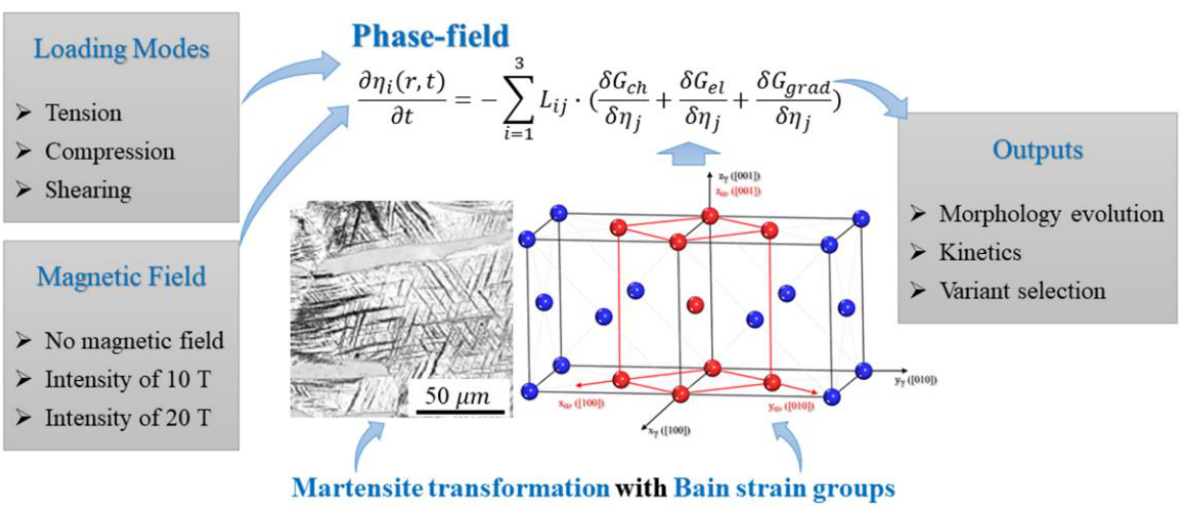
Figure 1. The framework of the phase-field simulation in this research. The bulk energy difference between austenite and martensite represents the driving force. The Landau-type free energy equation was employed to describe the energy evolution of the martensitic transformation, which is a function of the relevant physical variables and temperature [36,37]: